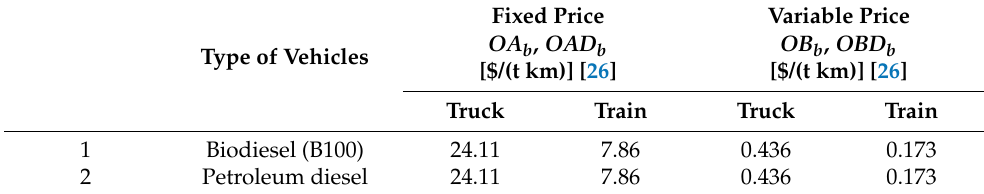
Table 7. Transport costs for the different vehicles for biodiesel (B100) and petroleum diesel